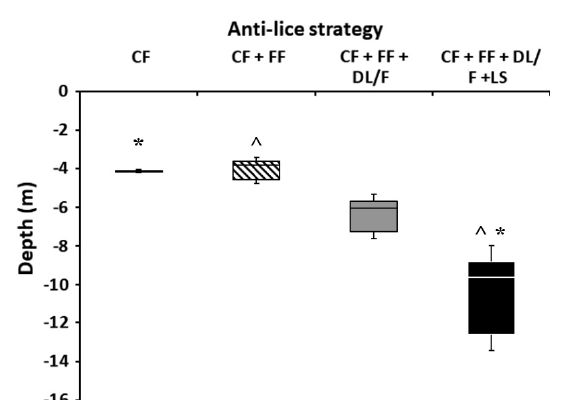
Fig. 3. Boxplots of mean salmon schooling depth for each anti- lice strategy, showing the third quartile (Q3) and first quartile (Q1) range of the data at the Vindsvik site from 30 August (Day 6) to 23 September (Day 30) 2017. CF: cleaner fish, FF: functional feed, DL/F: deep light and deep feeding, LS: lice skirts. Different symbols (* and ^) indicate significant